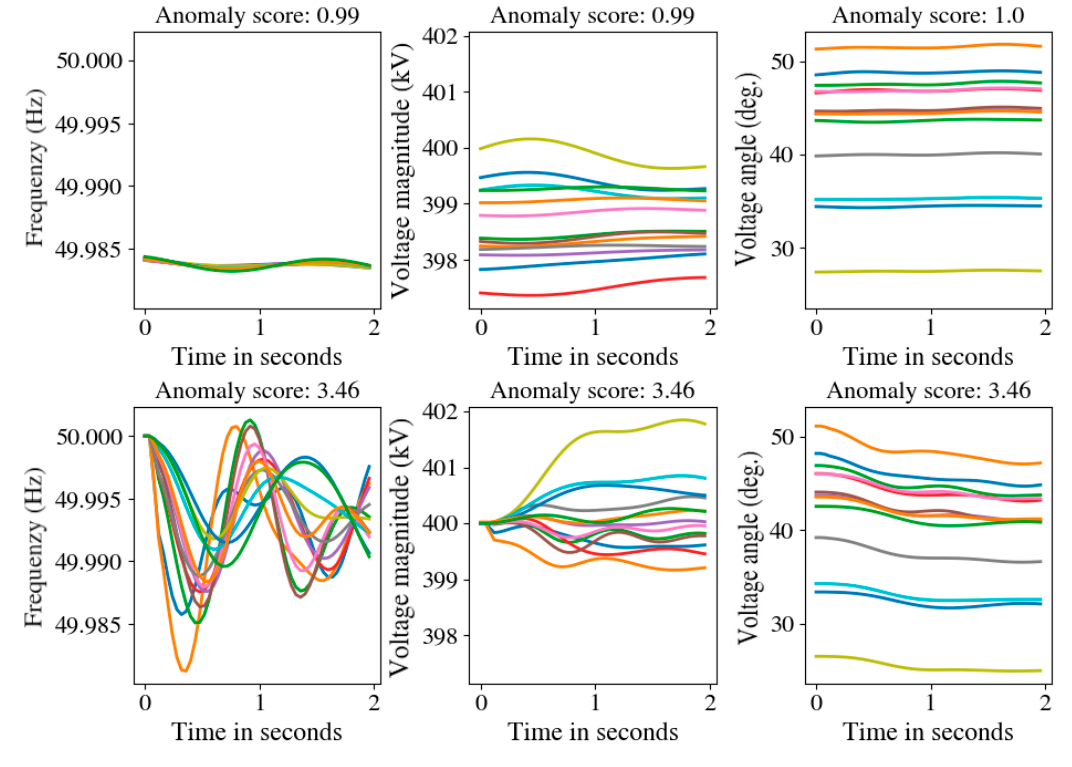
Figure 19. Example frequency ( top and bottom left ), voltage magnitude ( top and bottom middle ) and voltage angle ( top and bottom right ) patterns for low to medium anomaly scores ( top left to right ) and high anomaly scores ( bottom left to right ).